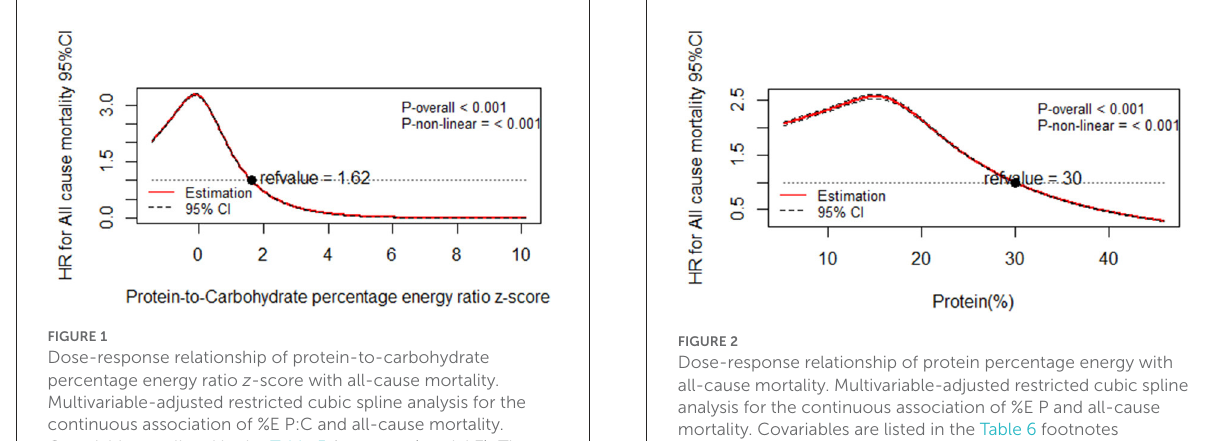
FIGURE2 Dose-response relationship of protein percentage energy with all-cause mortality. Multivariable-adjusted restricted cubic spline analysis for the continuous association of %E P and all-cause mortality. Covariables are listed in the Table 6 footnotes (isocaloric model). The y -axis shows the HRs for all-cause mortality for any %E P intake compared with the reference value set at 30% energy intake from protein. The black dot line indicates the 95%